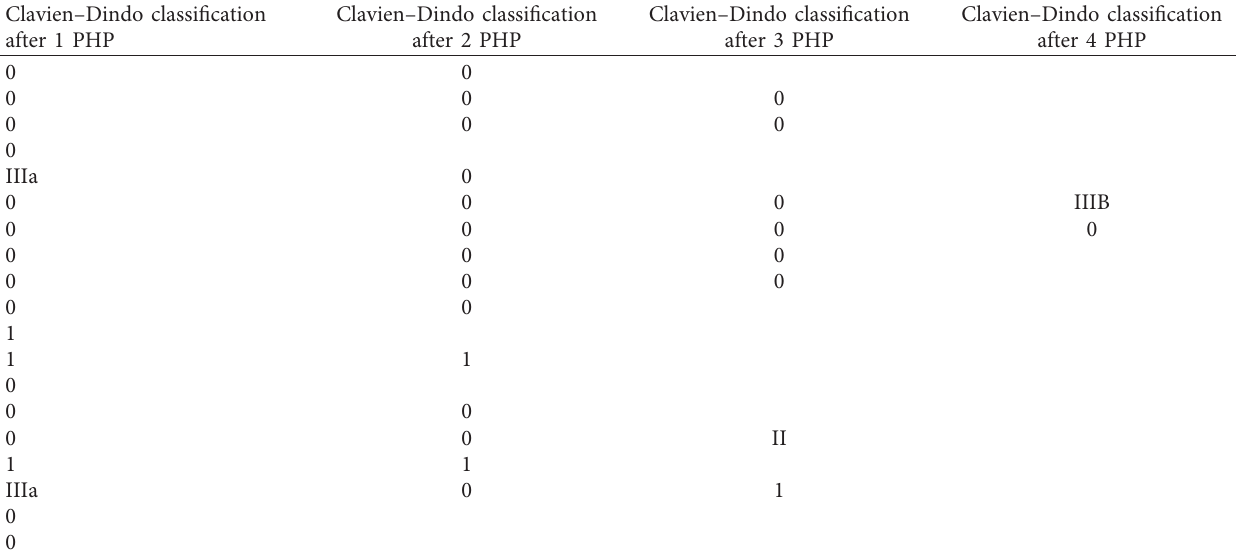
Table 2: Complications after PHP chemosaturation during hospital stay according to the Clavien–Dindo classification [18]. Clavien–Dindo